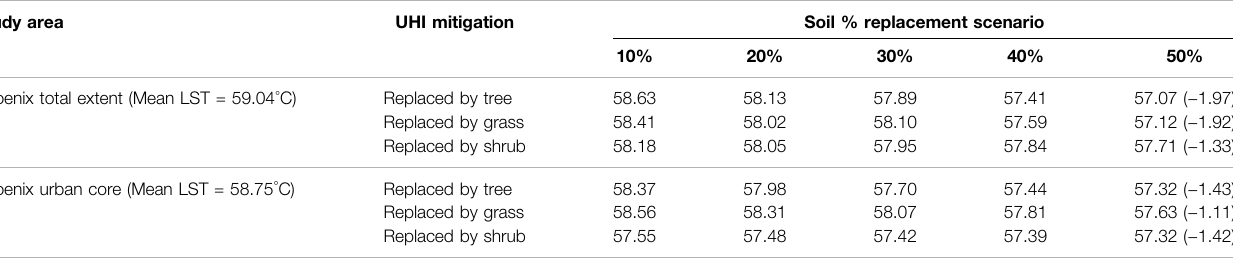
TABLE4| ProjectedmeansummerdaytimetemperaturesacrossPhoenixtotalextentandtheurbancorealonethatwouldresultfromreplacementof10,20,30,40,or50% of unmanaged soil by trees, shrubs, or grass, based on random forest (RF) scenario models. Study